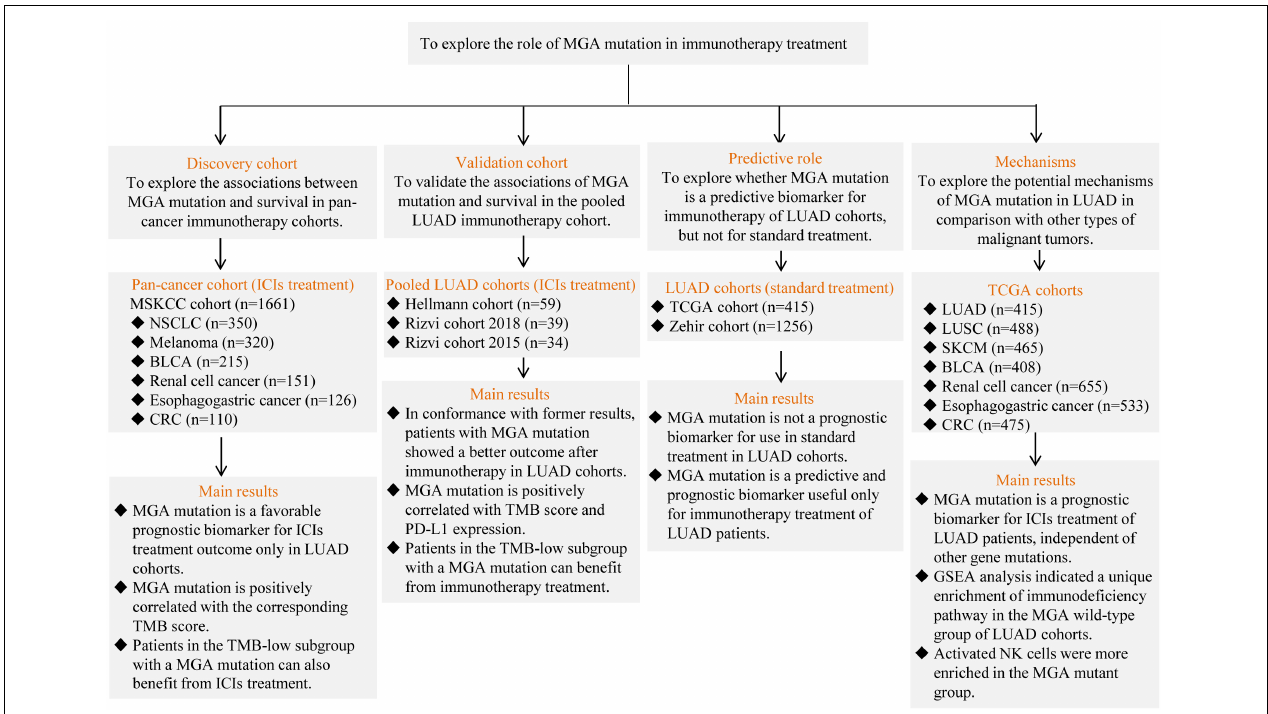
FIGURE 1 | The flow chart of the study. LUAD, lung adenocarcinoma; LUSC, lung squamous cell carcinomas; BLCA, bladder cancer; SKCM, skin cutaneous melanoma; CRC, colorectal cancer; ICIs, immune checkpoint inhibitors; TMB, tumor mutation burden; PD-L1, programmed death-ligand 1; MGA, Max’s Giant Associated protein; TCGA, The Cancer Genome Atlas; GSEA, gene-set enrichment analysis.